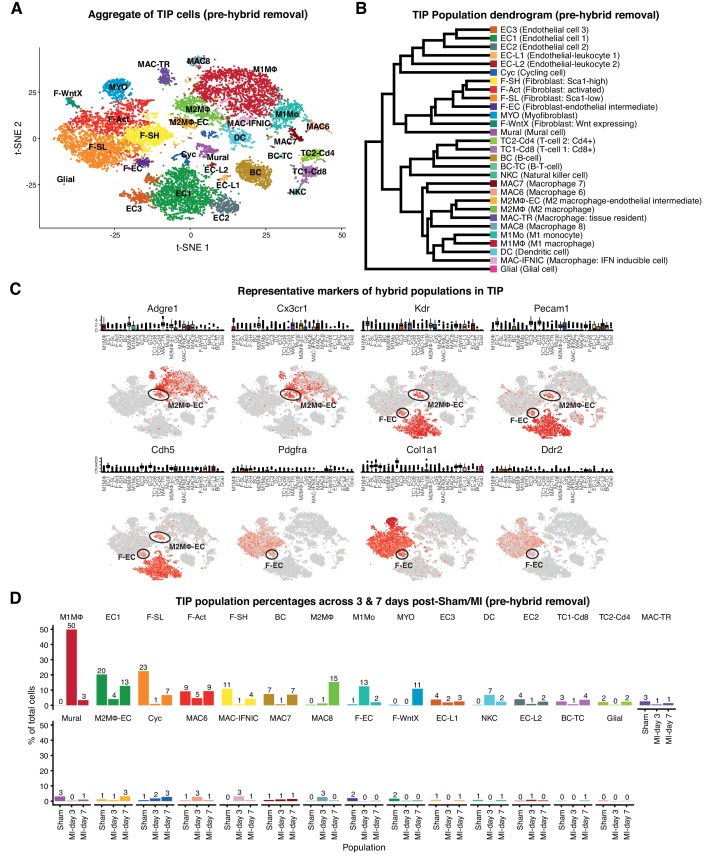
Clustering of TIP scRNA-seq prior to removal of minor hybrid populations.(A) t-SNE plot of aggregate TIP cells with all identified 29 sub-populations prior to filtering of minor hybrid populations. (B) Dendrogram of all 29 sub-populations according to average RNA expression. (C) Expression of example marker genes that illustrate hybrid populations (F-EC, M2MΦ-EC, EC-L1, EC-L2 and BC-TC) as visualized in box and t-SNE plots. (E) Percentage of total cells in each sub-population according to experimental condition.